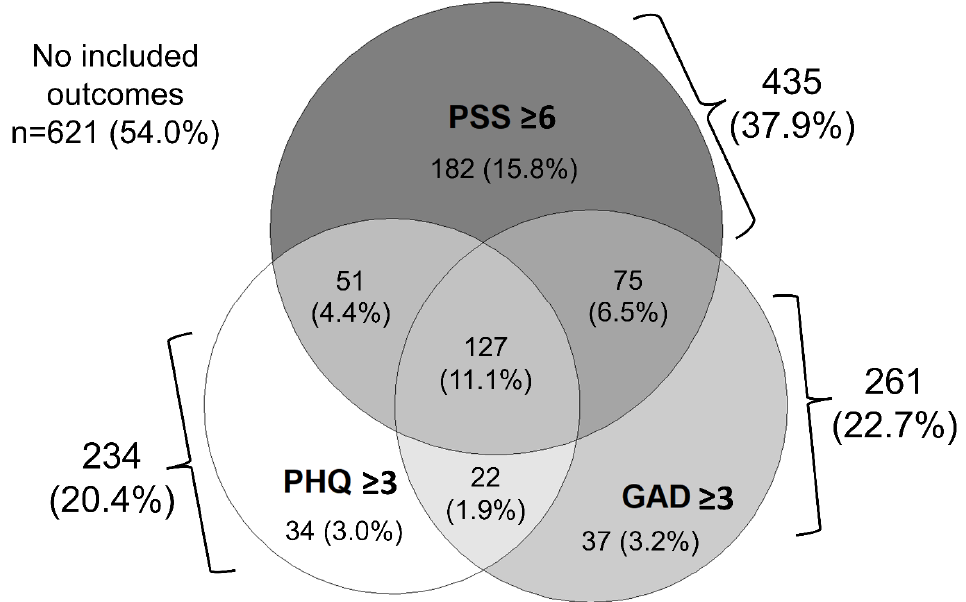
Figure 1. This Venn diagram shows the number of respondents who had one or more of the outcomes considered in this study. Of the n = 1149 respondents who had complete scores for all three outcomes, 528 respondents (46%) had at least one of the following: a PHQ-2 score ≥ 3, GAD-2 score ≥ 3, or PSS-4 score ≥ 6, and 11.1% of respondents had all three.